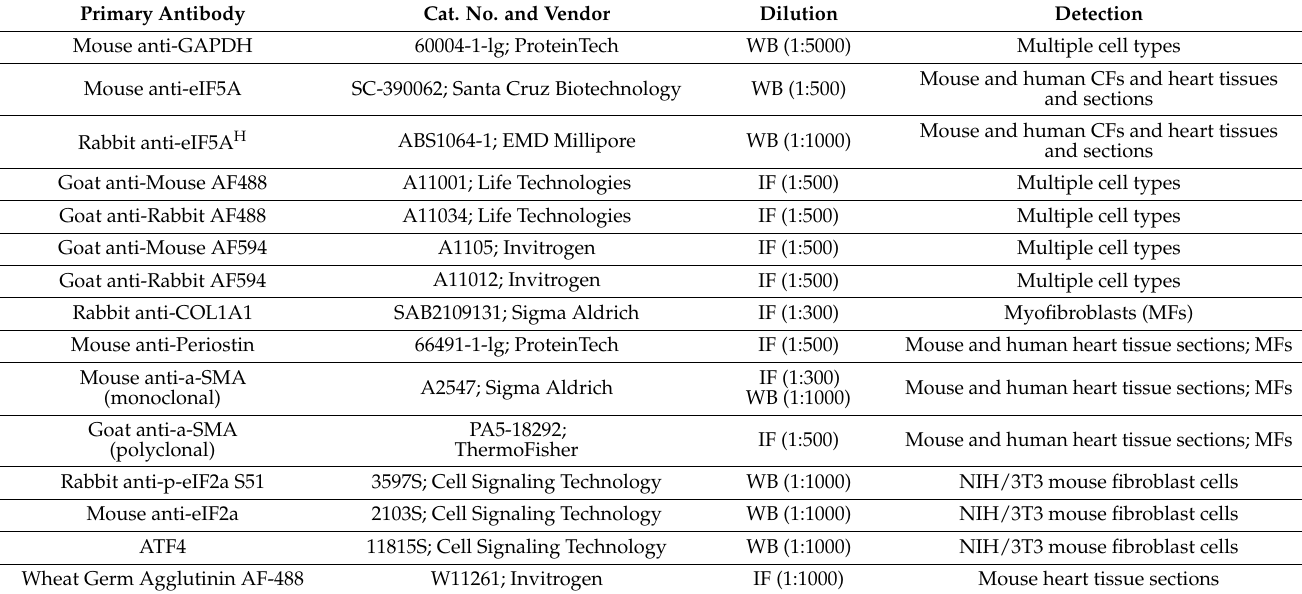
Table 1. Antibodies used in this